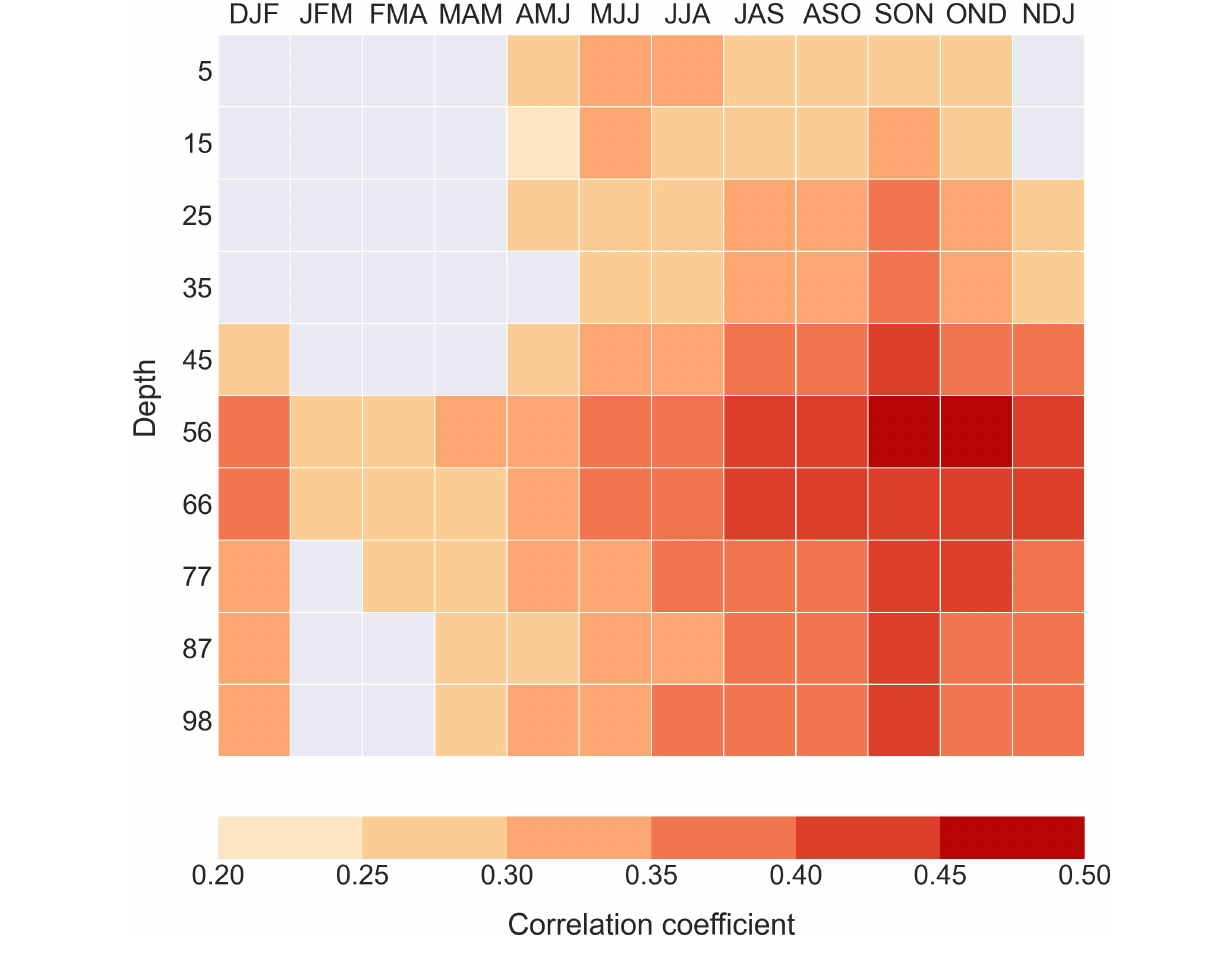
FIGURE 2 | Pearson correlation coefficient ( p < 0.01) between the ARMC and subsurface temperature signal extracted from EN4.2.1 dataset (Good et al., 2013) at the collection site (66 ◦ N, 18 ◦ W) for the 1900–2005 period. The correlation coefficients for p > 0.01 are not shown (gray